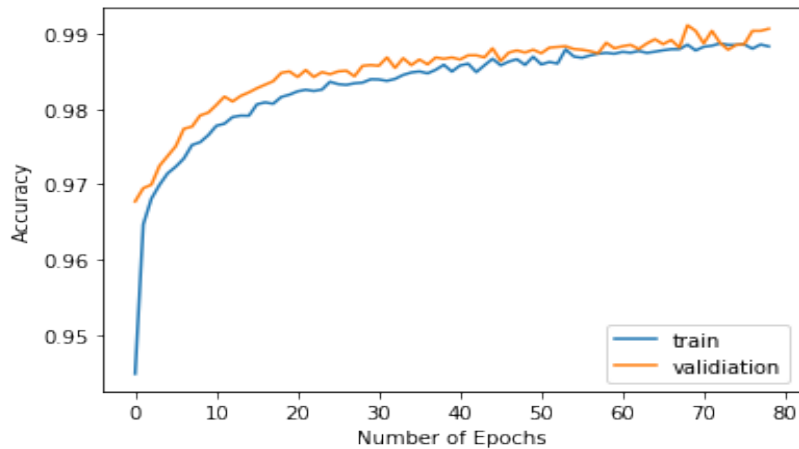
Figure 11. Model accuracy in training and validation phases in second layer.